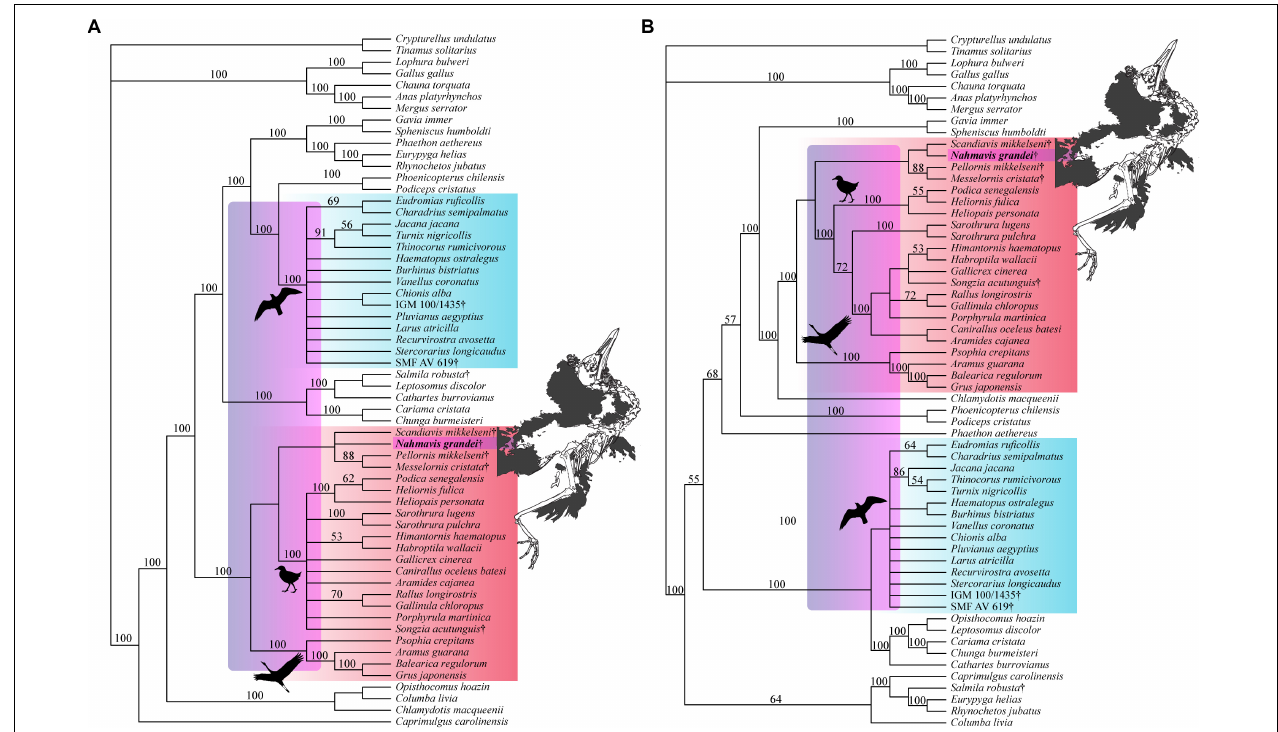
FIGURE 5 | Strict consensus trees recovered from heuristic parsimony analyses using (A) Prum et al. (2015) (75 MPTs, 5,244 steps, CI = 0.163, RI = 0.463, RC = 0.075, HI = 0.837) and (B) Reddy et al. (2017) (84 MPTs, 5,260 steps, CI = 0.162, RI = 0.461, RC = 0.075, HI = 0.838) trees as molecular backbone constraints. Charadriiform, gruoid and ralloid silhouettes are placed at the crowns of their respective clades. Charadriiformes are highlighted in blue, Gruiformes are highlighted in red, and violet spans the possible phylogenetic placements of Nahmavis grandei across these clades. All extinct taxa are denoted with daggers. Bootstrap support values greater than 50% are denoted above